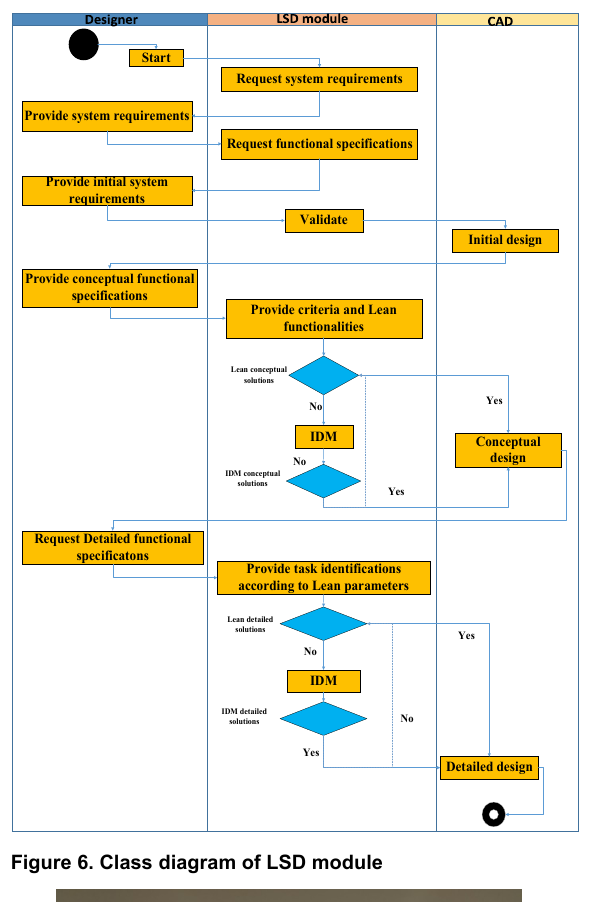
Figure 6. Class diagram of LSD module